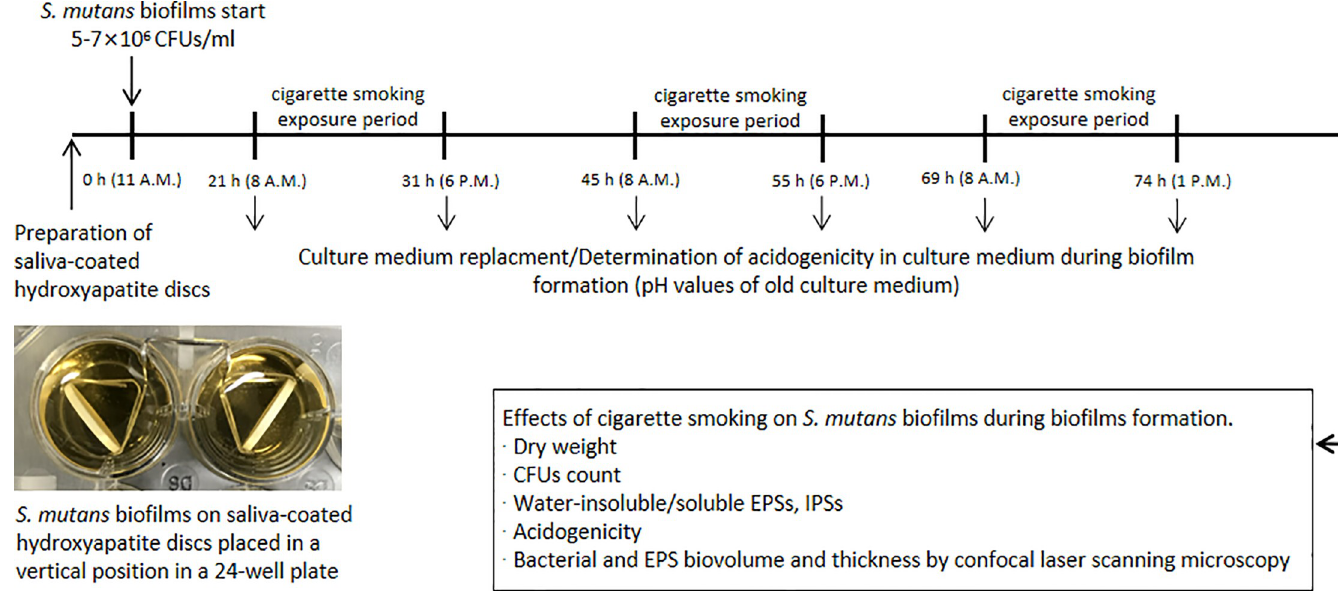
Fig 1. S . mutans biofilms formation and experimental scheme.